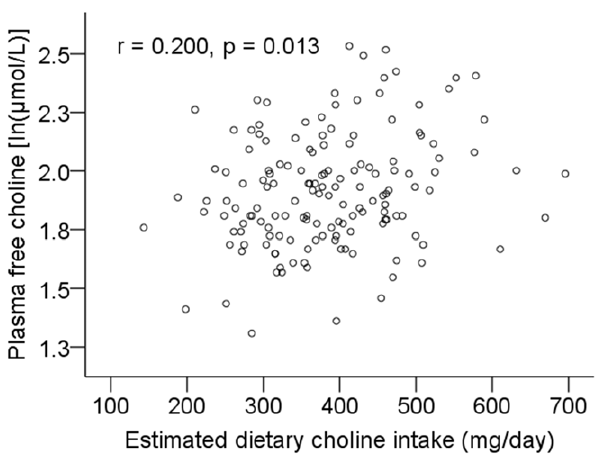
Figure 3. Scatter plot to show the correlation between estimated maternal choline intake and plasma free choline. The results for plasma free choline were skewed and transformed to natural log values for analysis, r=0.200, p=0.013.